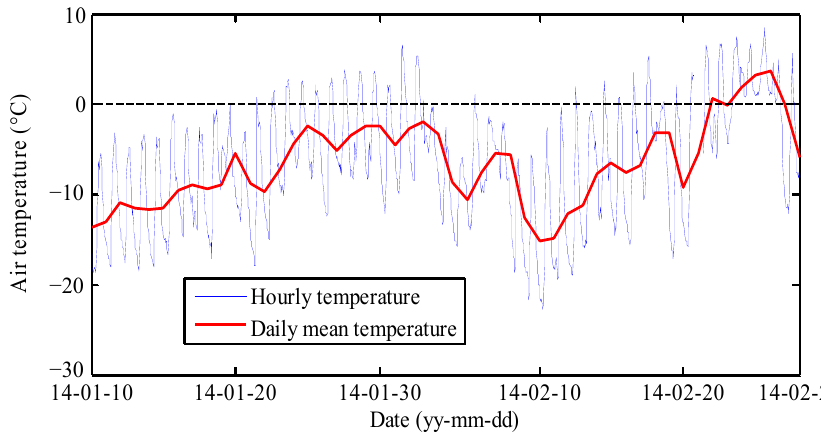
Figure 11. Results of atmospheric temperature monitoring.